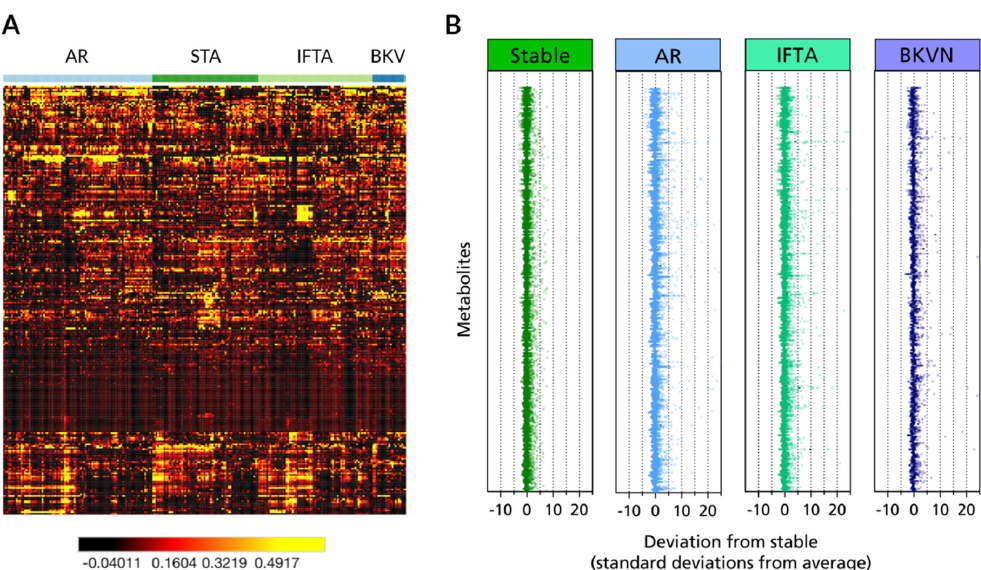
Figure 2. Metabolomic profiling of renal transplant outcomes. ( A ) Heat map representation of unsupervised hierarchical clustering by metabolite (rows) grouped by transplant phenotype (columns). Shades of black to red to orange to yellow represent continuous increases of a metabolite relative to the median metabolite levels (see color scale). ( B ) z-score plots for the data in a normalized to the mean of the stable phenotype urine samples (truncated at 25 s.d. for clarity).